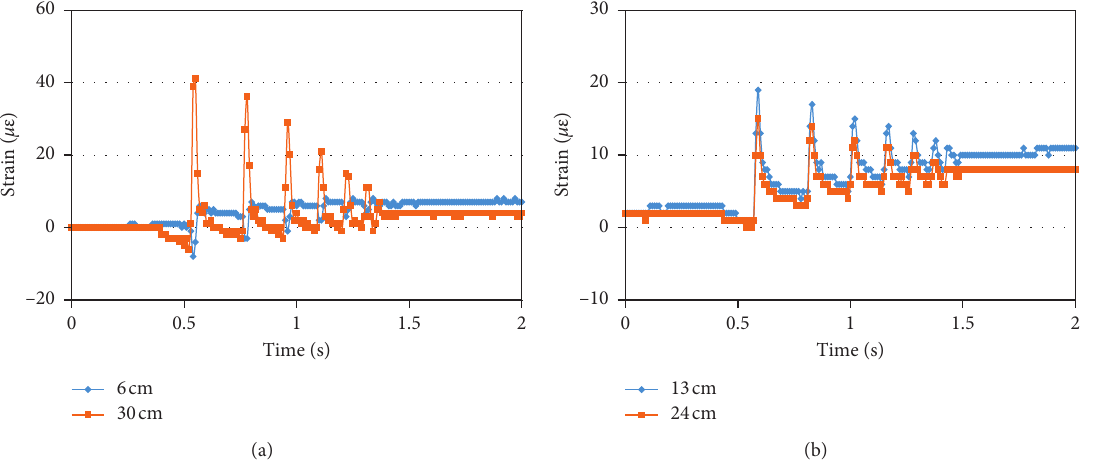
Figure 7: Typical strain pulses of asphalt layer under FWD loading for (a) flexible pavement and (b) semirigid